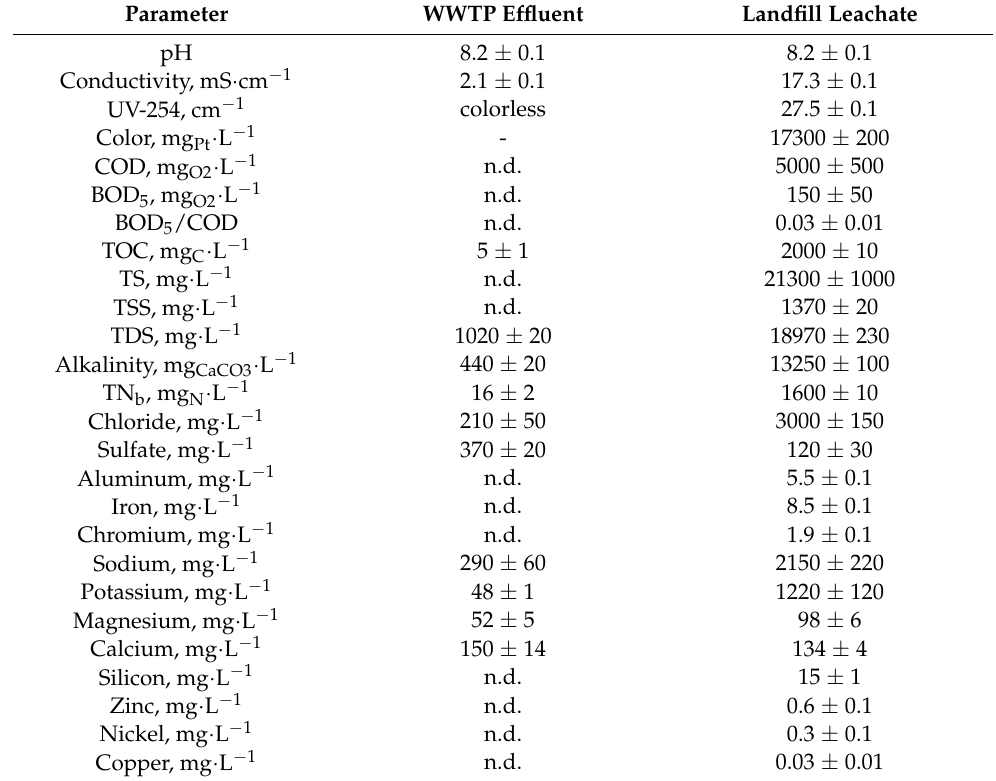
Figure 8. Effect of water matrix (ultrapure, WWTP effluent, landfill leachate) on the removal of TOC by CWPO. Reaction conditions: 50 mL reaction volume, 500 mg · L − 1 catalyst, 250 mg · L − 1 H 2 O 2 , 200 rpm, 50 ◦ C, 240 min reaction time. Initial TOC: 80 mg · L − 1 ultrapure water, 90 mg · L − 1 WWTP, and 100 mg · L − 1 landfill leachate. Table 7. Characteristics of the wastewater treatment plant effluent (Garray, Soria, Spain) and landfill leachate (Golmayo, Soria,